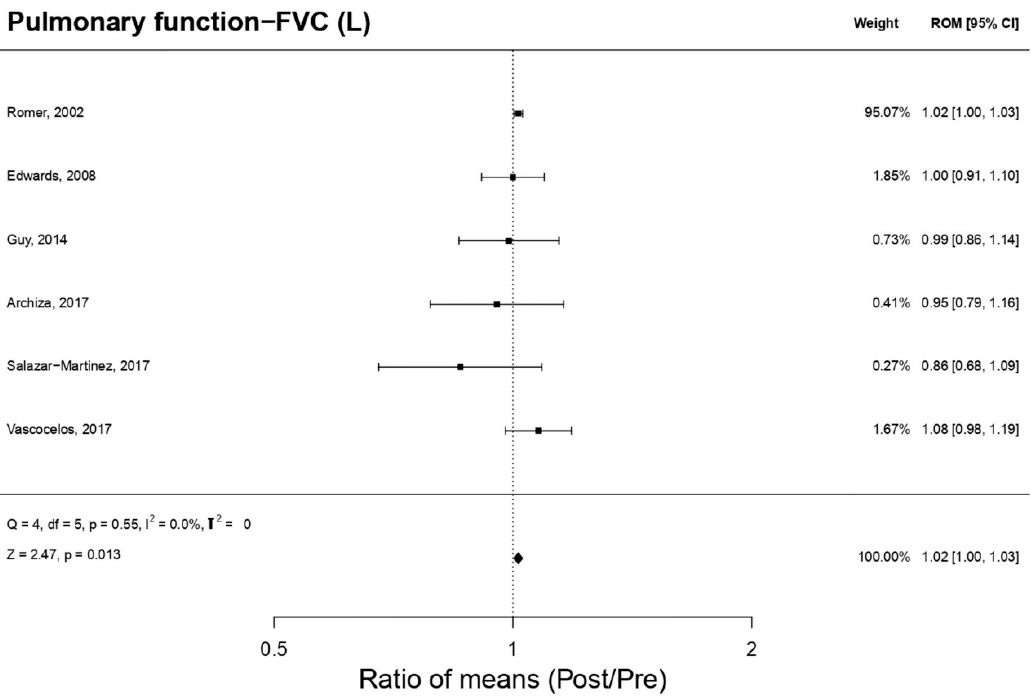
Figure 3. Funnel Plot meta-analysis results for Maximal Pressure Inspiratory.